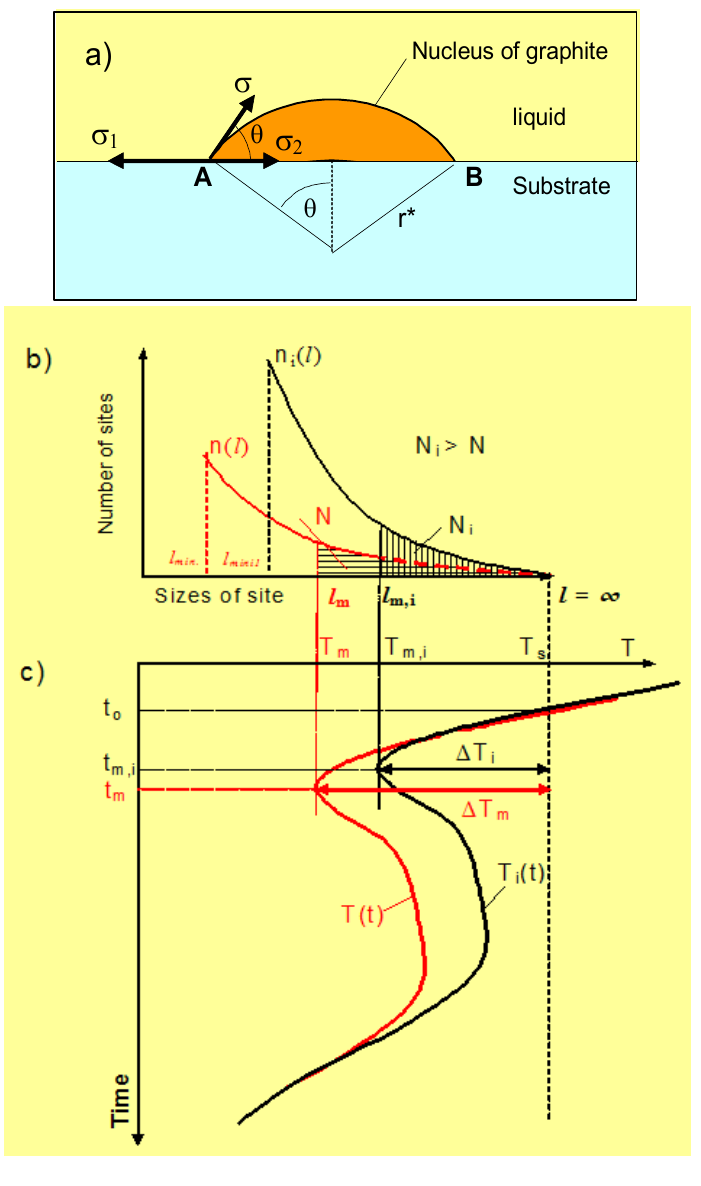
Figure 9. ( a ) Graphite nucleus on a substrate ( b ), size distribution for graphite nucleation sites and ( c ) cooling curves T ( l ) and T i ( l ) for two physical-chemical states of cast iron